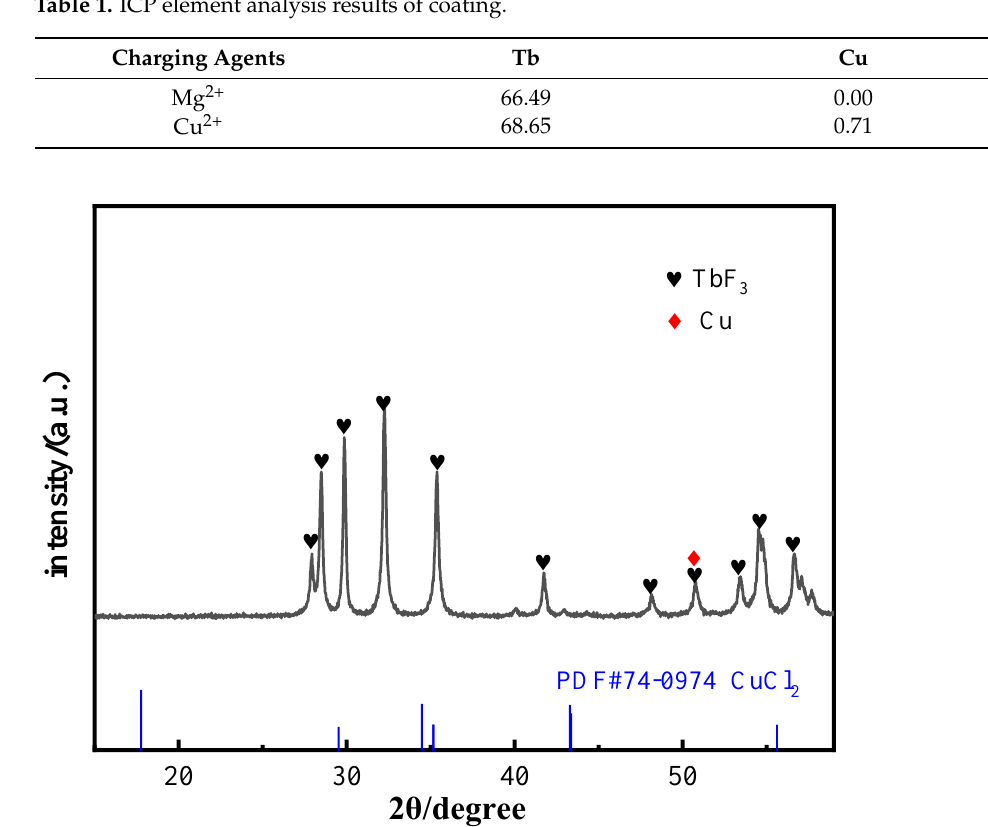
Figure 6. XRD results of EPD coating with Cu 2+ charging agents.